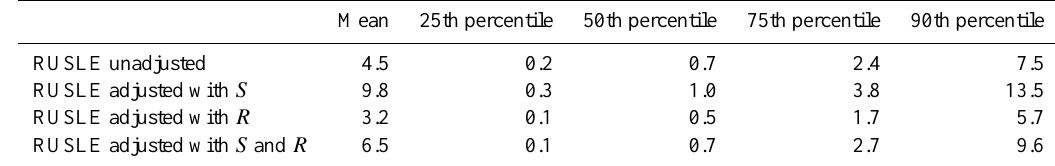
Table 8. Comparison of the global erosion rates (tha − 1 year − 1 ) and percentiles between different versions of the RUSLE model.